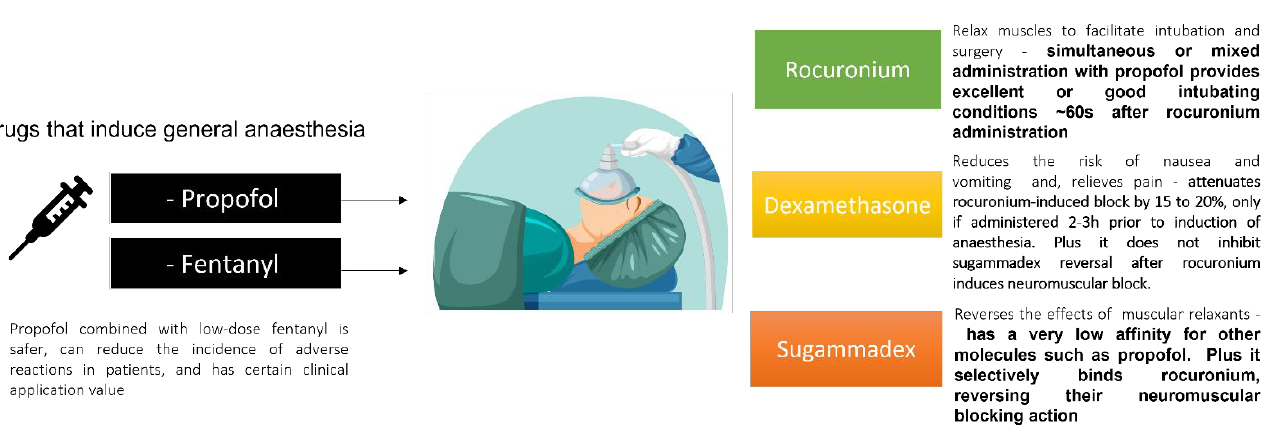
Figure 3. Correlation between the five drugs used during the induction of anesthesia.